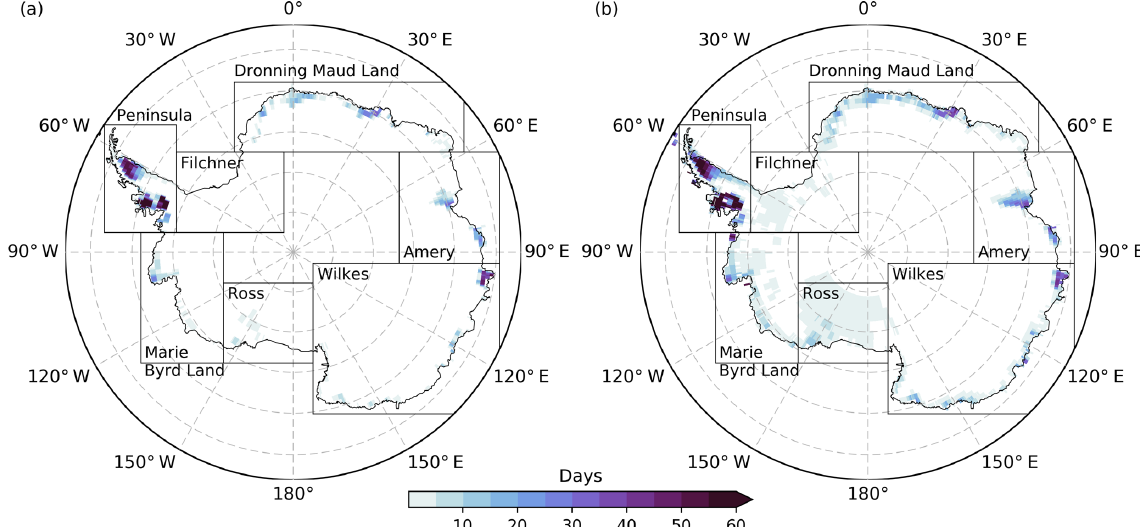
Figure 3. Annual mean of melting duration (days) from April 2010 to March 2018 detected with observations (a) at 1.4GHz (SMOS) and (b) at 19GHz (SSMIS). Seven regions are outlined.